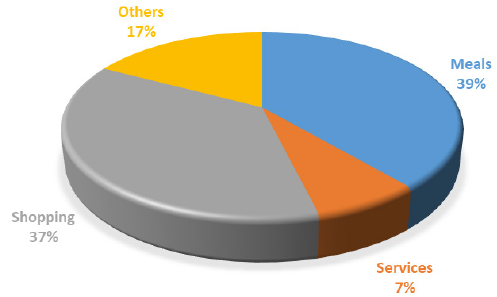
Figure 4. Distribution of the participants’ local expenditure (%)